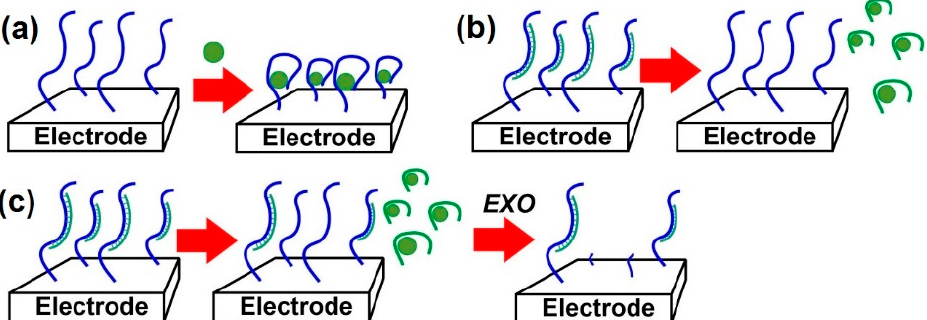
Figure 5. Electrochemical aptasensors for antibiotics based on the monitoring of the surface layer permeability: ( a ) aptamer folding after analyte recognition; ( b ) analyte removes aptamer from its hybrid with capturing DNA attached to the electrode; ( c ) Remained single-stranded DNAs are additionally cleaved with exonuclease.